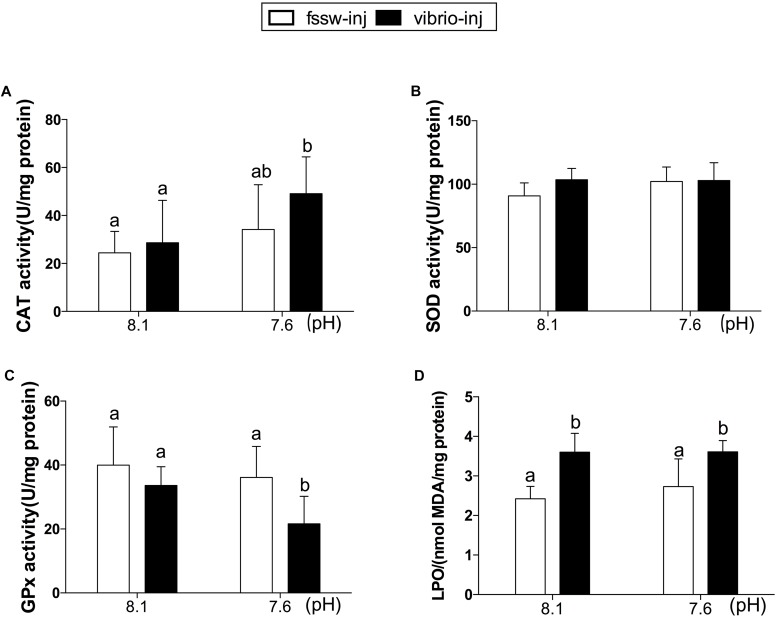
Antioxidant enzyme activities and LPO levels in the gills of C. gigas post elevated pCO2 and/or V. splendidus exposure. (A) CAT. (B) SOD. (C) GPx. (D) LPO. Each bar represents mean ± SD (n = 6). Different letters indicate significant differences among different treatments (p < 0.05).